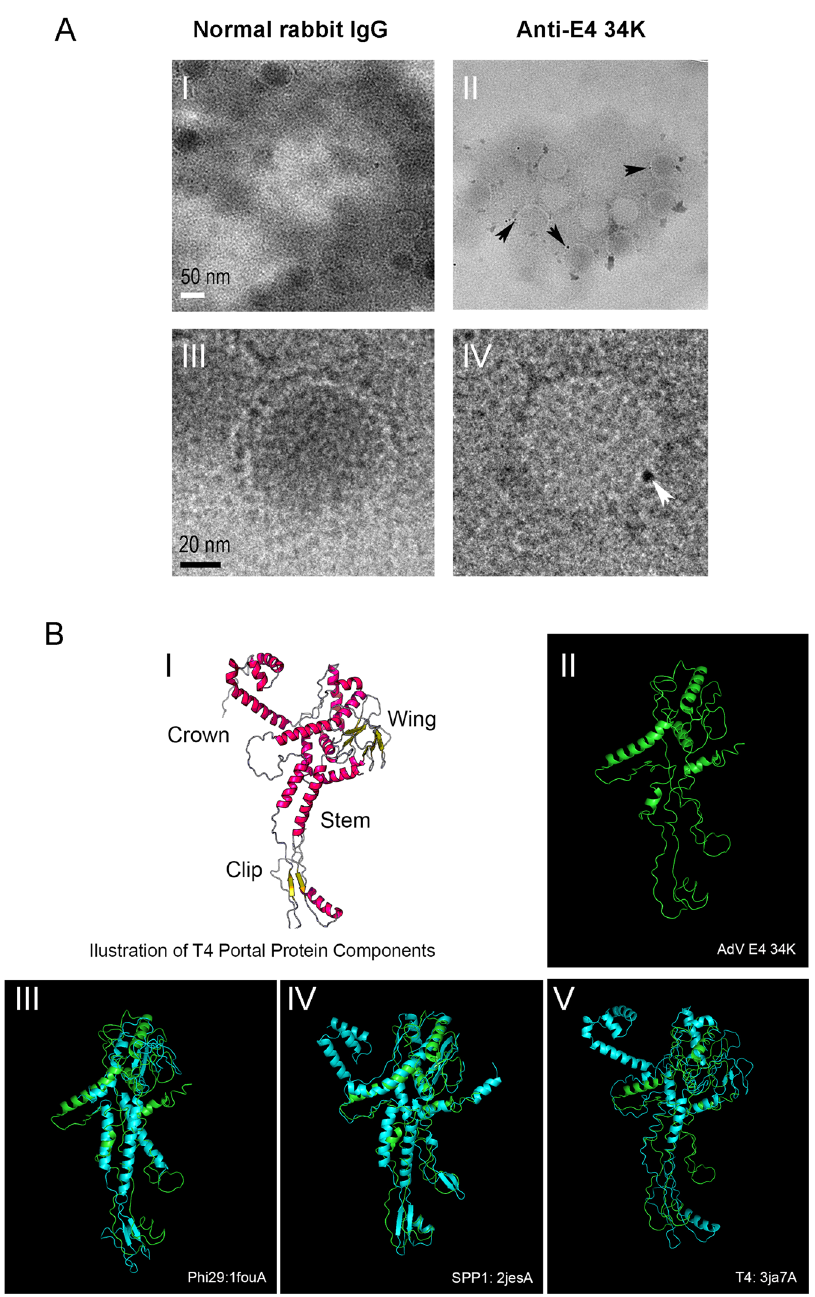
Figure 3. (A) Immunogold EM of HAdV-C5 particles labeled with anti-E4 34K antibody. A purified HAdV-C5 preparation was applied to the grids and treated with anti-E4 34K antibody or normal rabbit IgG followed by treatment with anti-rabbit antibody conjugated to 6 nm gold particles. The grids were examined by transmission electron microscope (TEM) with a Philips CM200FEG electron microscope. The low magnification photos were taken at 13.5K and the high magnification photos were taken at 58K using a Gatan Ultrascan4000 CCD camera. ( B ) Predicated tertiary structure of AdV E4 34K. I Predicted tertiary structure of a single subunit T4 portal protein by RaptorX 48 , which is close to the recently published T4 portal structure 31, 34, 35 , suggesting that the predicted structure is identical in most parts with the experimental one. A typical viral portal protein contains a crown, wing stem and clip 31, 34, 35 . II Predicted tertiary structure of AdV E4 34K by I-TSAASER using template guiding model. III–V E4 34K (green) is superimposed with a single subunit of SPP1 (2jesA, TM-score = 0.637), T4 (3ja7A, TM-score = 0.513), and Phi29 (1fouA, TM-score = 0.391) portal proteins 31, 35, 49